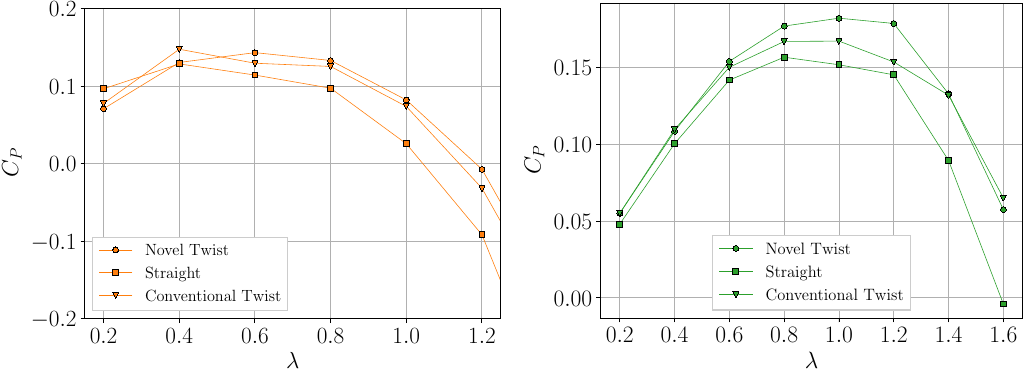
Figure 8. Numerical values of C P as function of λ for SAWINT (left) and SAVANT (right) turbines for different geometric blade